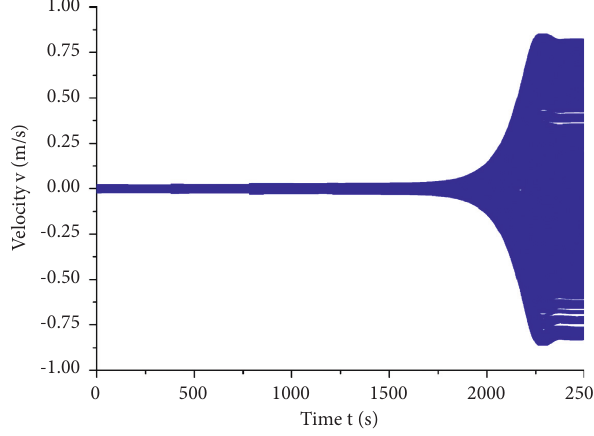
Figure 16: Midspan velocity time history curve.